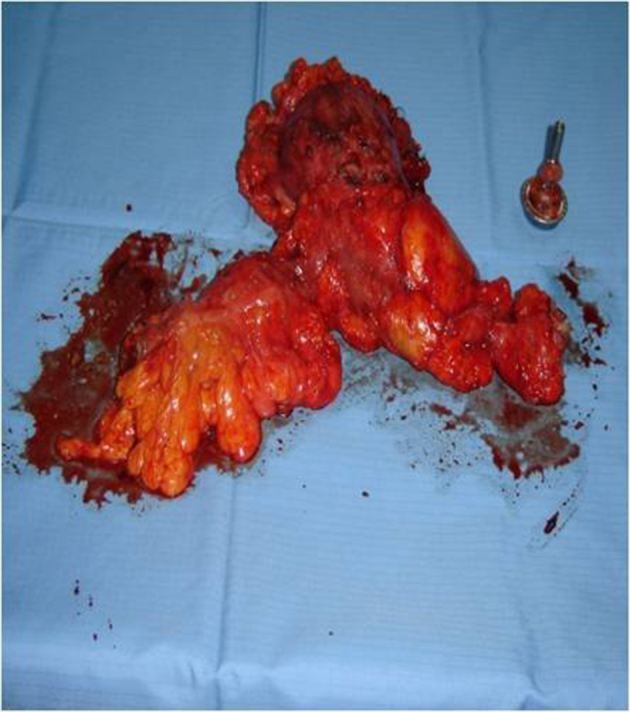
Operative specimen.